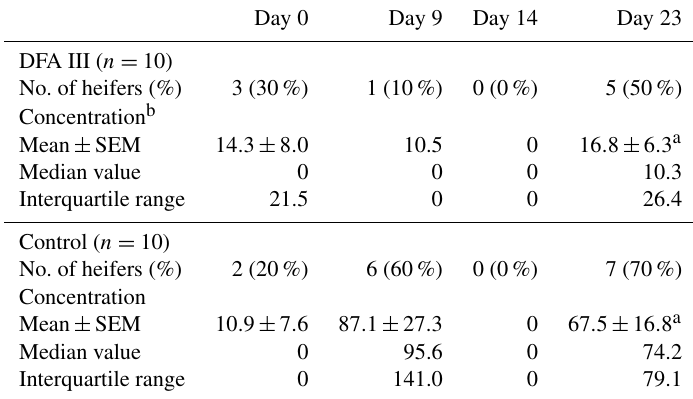
Table 1. Results of the analysis of the number of heifers in which the concentration of STC was above the limit of detection (LoD) during the study period, as well as the concentration of STC (measured as pgmg − 1 creatinine) in the urine (mean ± standard error of the mean, SEM) with or without DFA III supplementation.